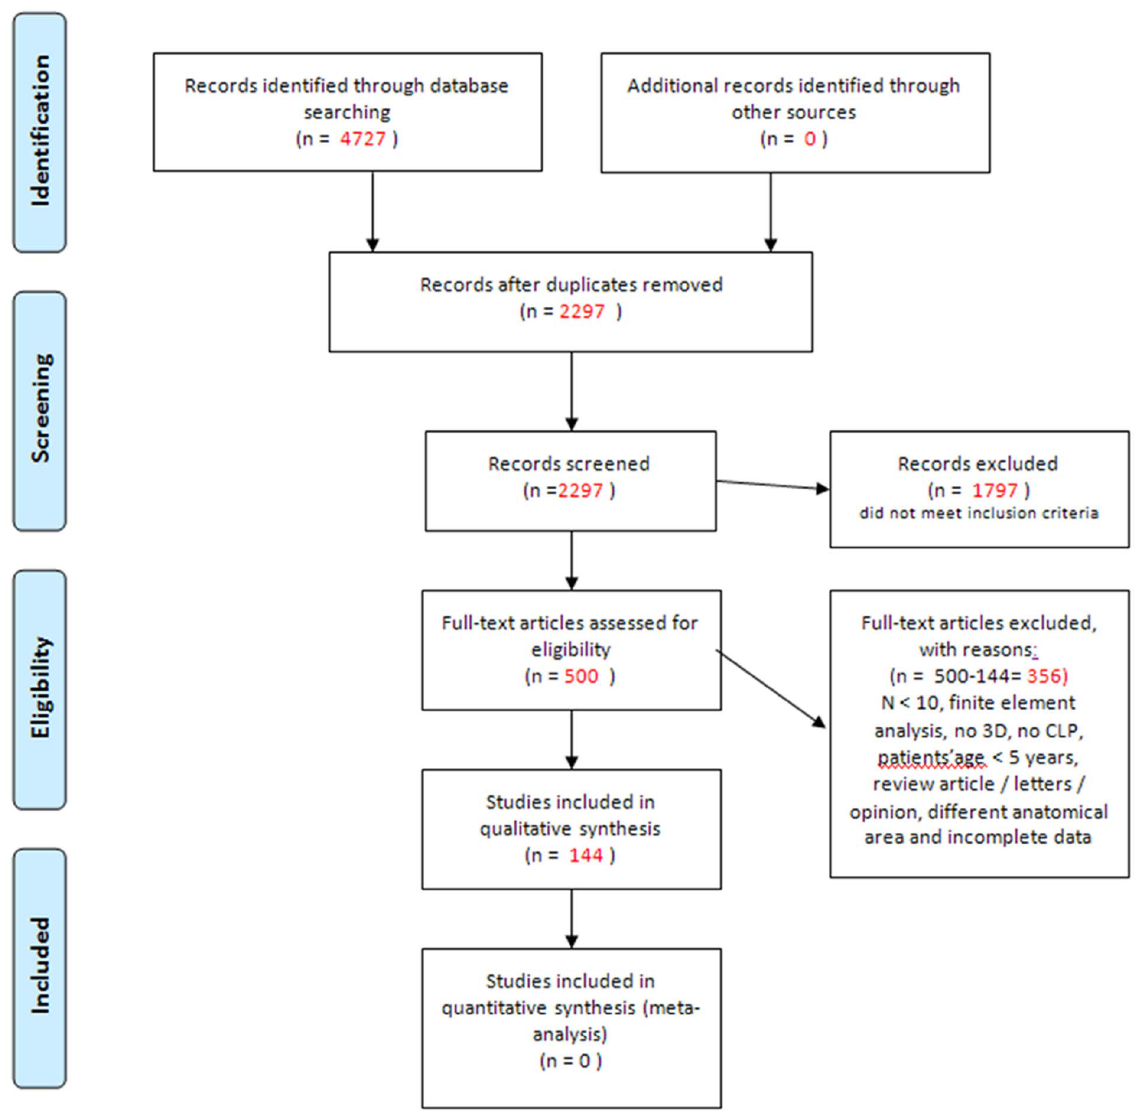
Figure 1. PRISMA flow chart of the study selection process.